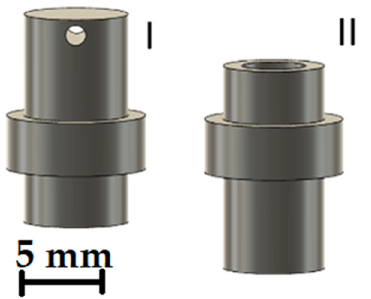
Figure 16. CAD drawing of the bolts for the capillary ( I ) and the magnetic support ( II ).